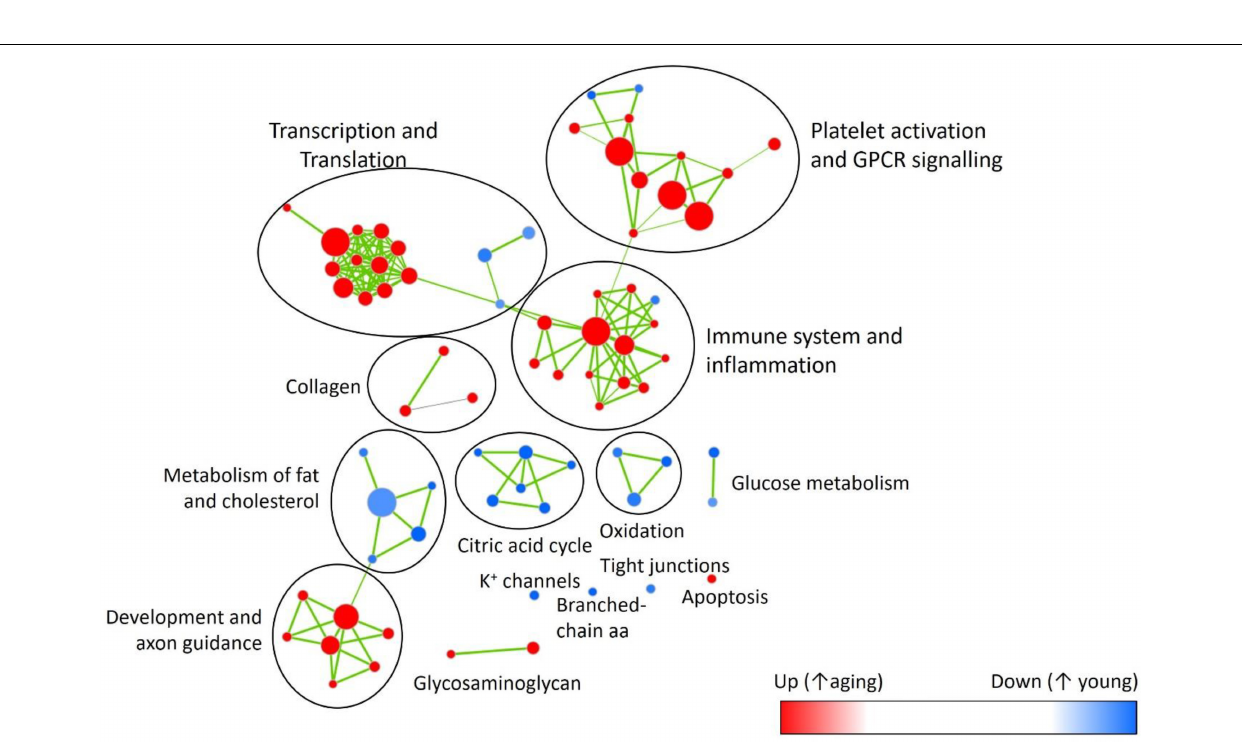
Frontiers in Physiology |